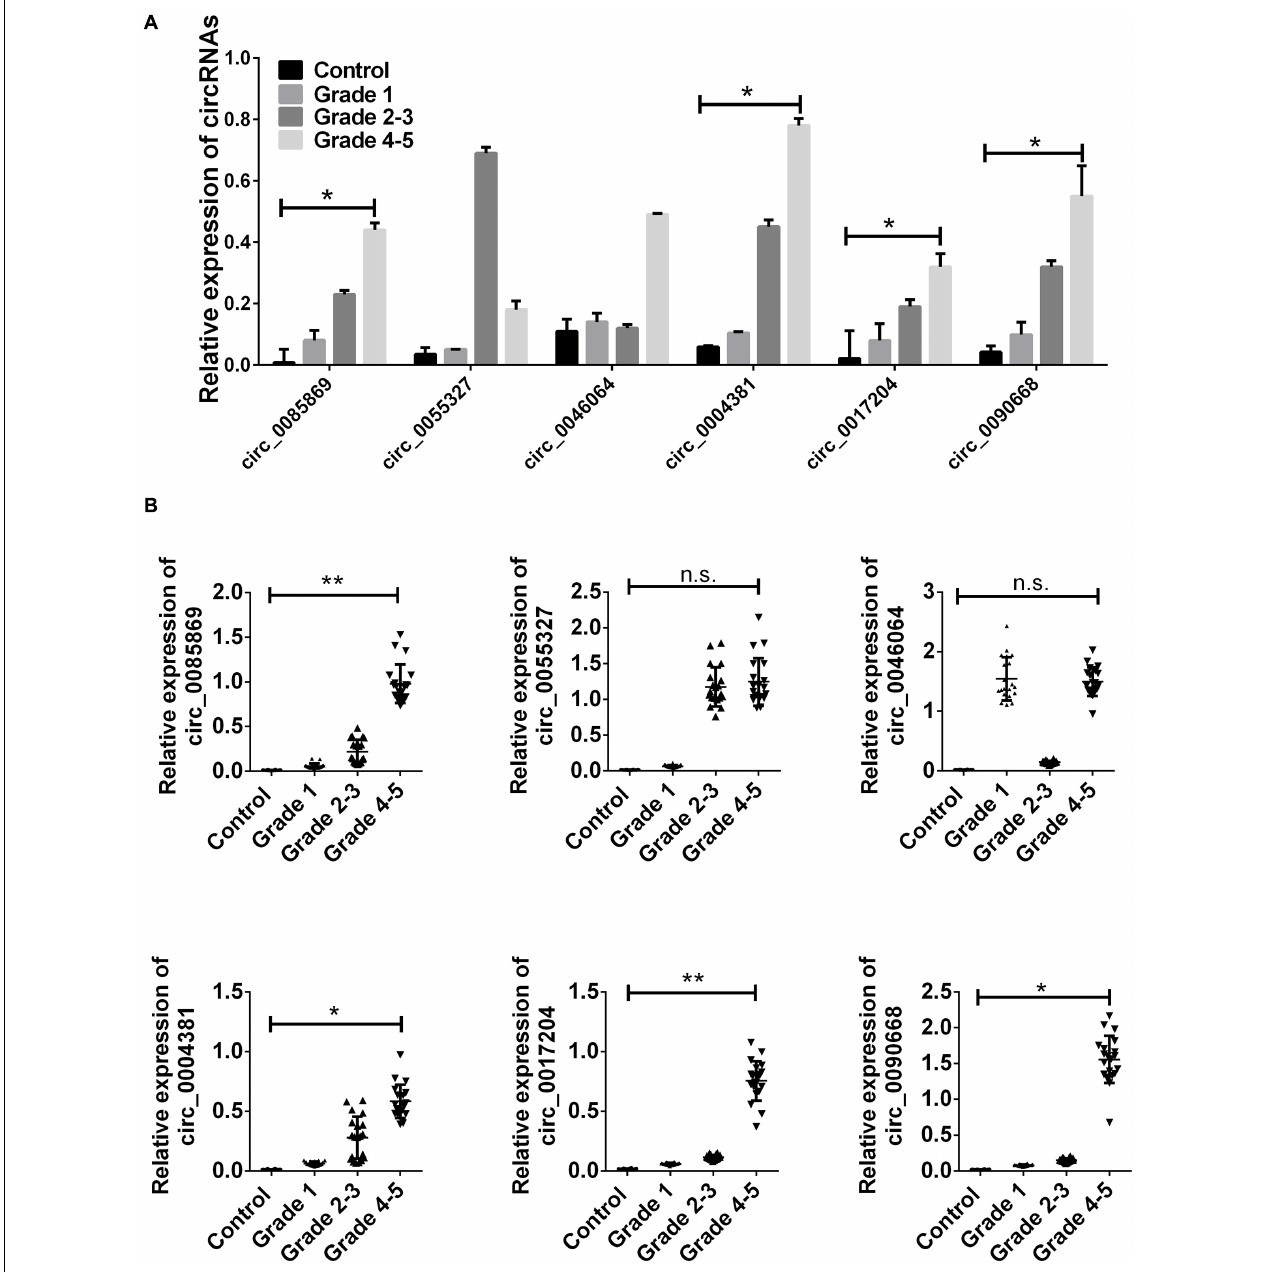
FIGURE 2 | CircRNA expression in training set. (A) The relative expression level of six circRNAs in PD patients and healthy control used in microarray detection. (B) Total 20 paired plasma from PD patients in each group, and 20 controls were used in RT-qPCR analysis. Data was presented as mean ± SEM. Data was analyzed with student t -test. n.s. indicated no significant, * indicated p < 0.05 and ** indicated p <